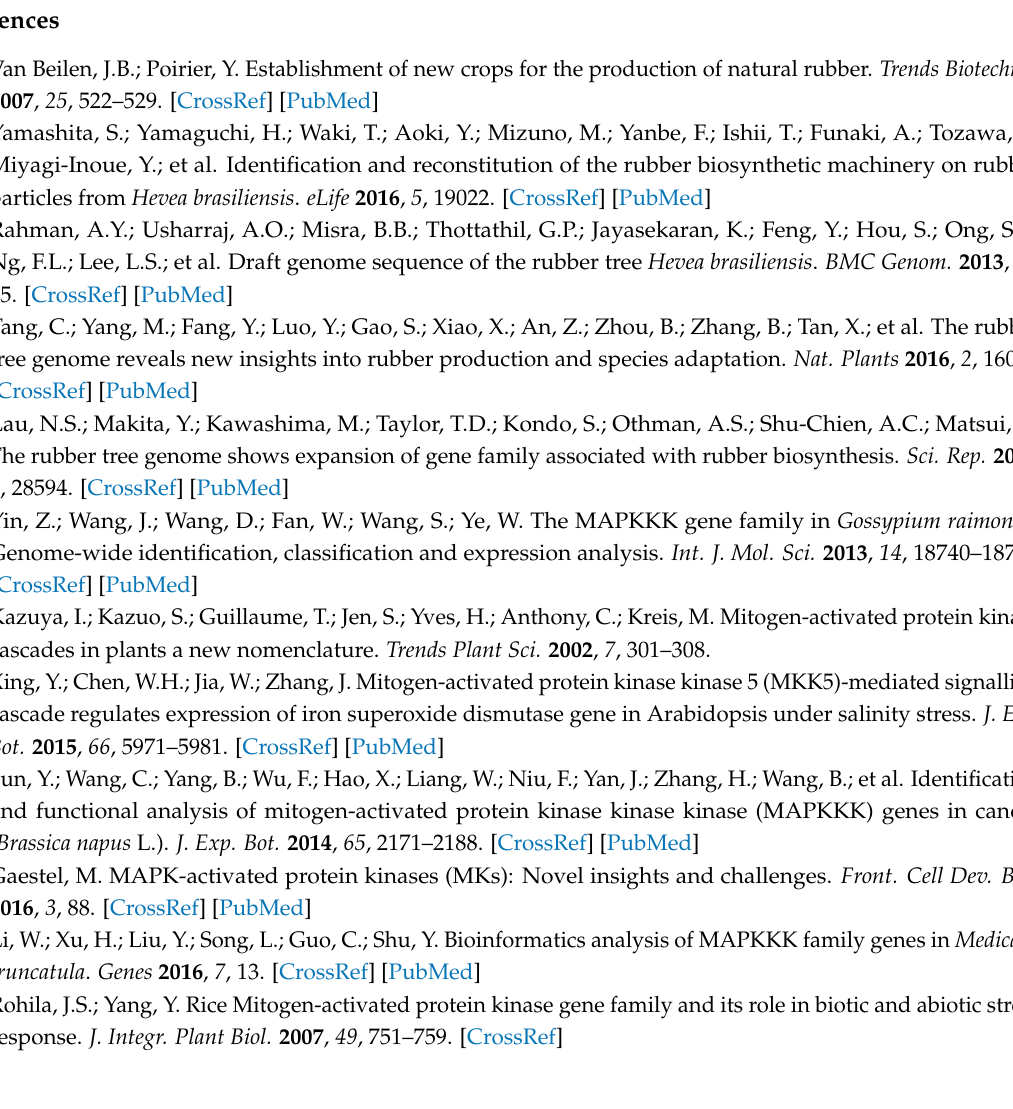
S1: Primers used for PCR. Table S2: Putative cis -element sequences in the promoter regions of HbMPK genes. Figure S1: Raw spectra of peptides mapped to HbMPK proteins. Figure S2: Phylogenetic and exon-intron structure analyses of MPK genes in M. esculenta ( Me ) and Hevea ( Hb